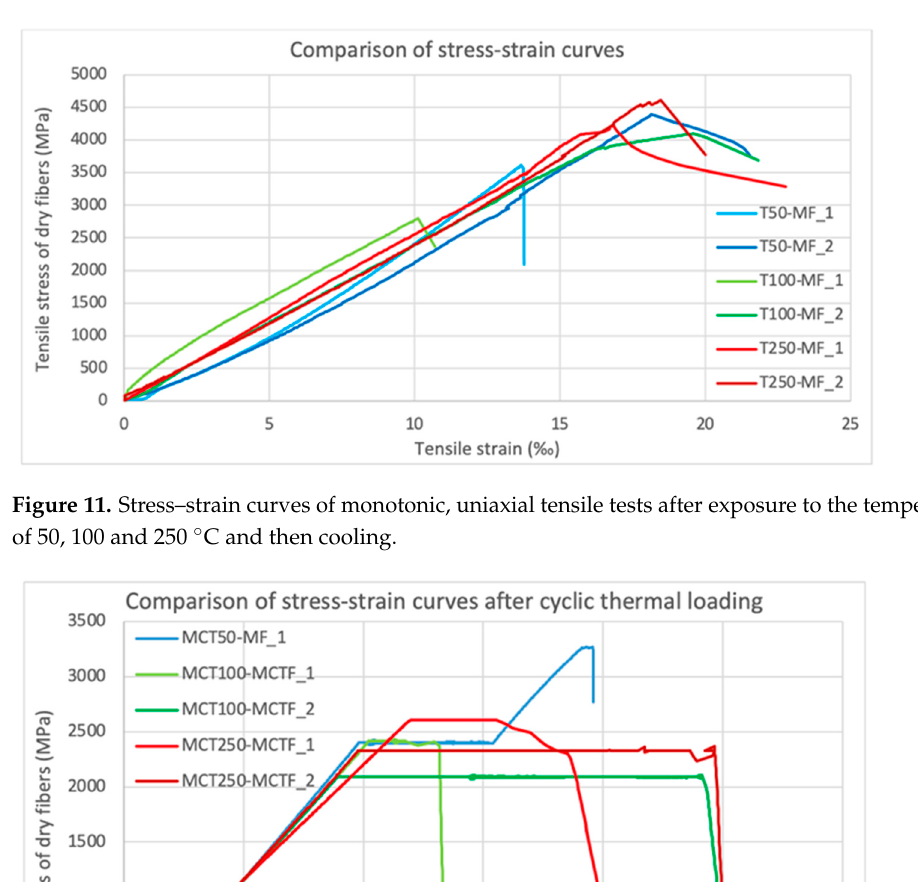
Figure 11. Stress–strain curves of monotonic, uniaxial tensile tests after exposure to the tempera- tures of 50, 100 and 250 °C and then cooling.